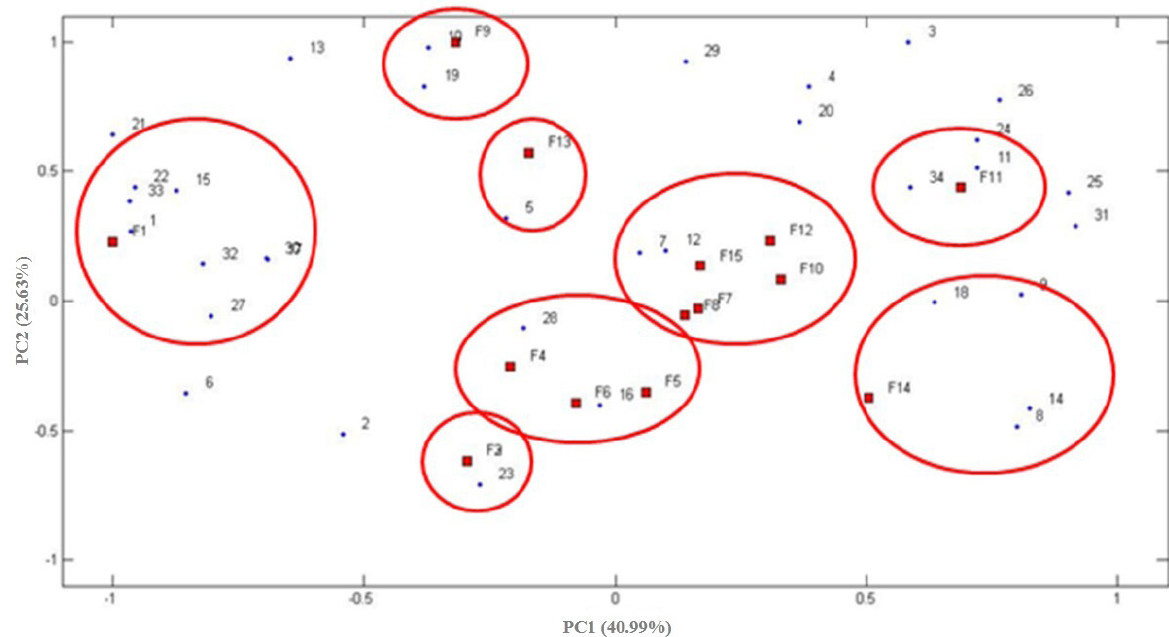
Figure 3. Principal component analysis for the different sugar-free banana preserves formulations. * Formulation 15: average of sensory analysis values obtained by formulations 15, 16, 17 and 18. Descriptors: 1 - characteristic appearance of banana preserve, 2 - strong brown color, 3 - faint brown color, 4 - lighter color than ideal, 5 - darker color than ideal, 6 - ideal color, 7 - bright, 8 - matte, 9 - opaque, 10 - translucent, 11 - lumpiness, 12 - syneresis, 13 - strong banana aroma, 14 - faint banana aroma, 15 - sweet aroma, 16 - burnt aroma, 17 - pleasant aroma,